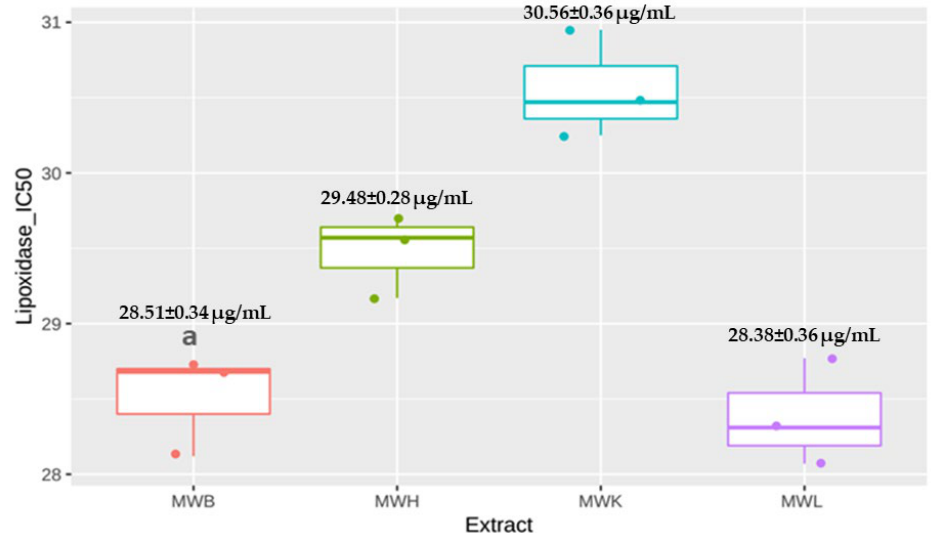
Figure 2. Effect of J. regia methanolic extracts on Lipoxygenase activity. a p < 0.05, Data expressed as mean ± SD. Abbreviations—MWB: Methanolic Extract of bark, MWH: Methanolic extract of Husk, MWK: Methanolic Extract of Kernels, MWL: Methanolic Extract of Leaves.